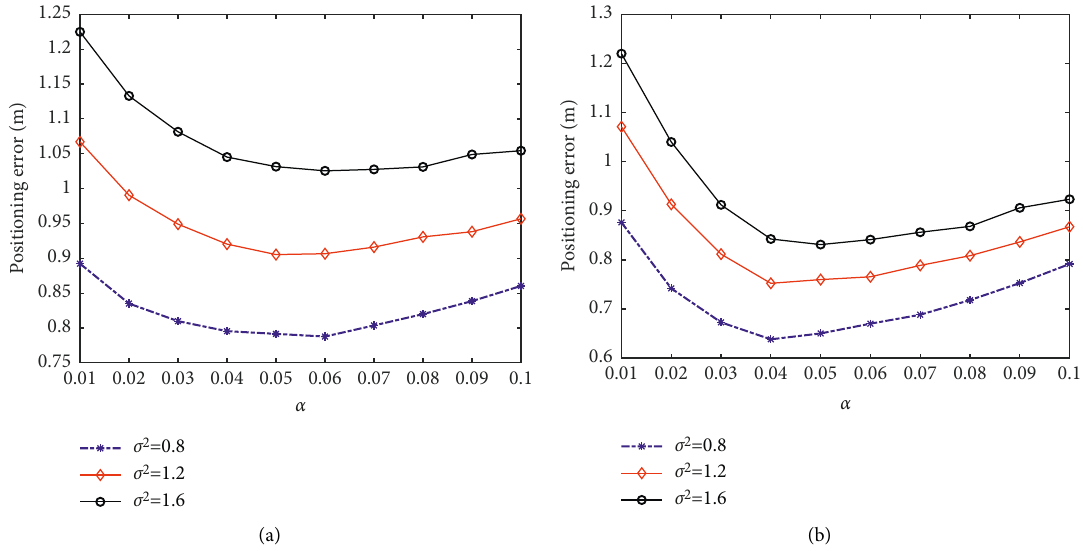
Figure 4: Influence of different search step size on positioning error. (a) I � 8, K � 4; (b) I � 16, K �